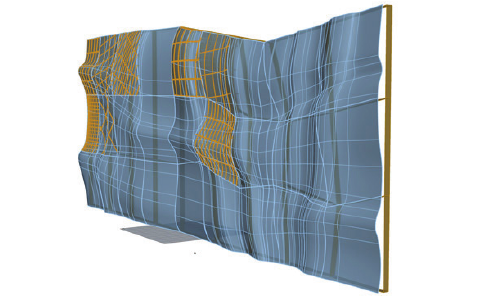
Figure 2. Entire wall panel sized 540x210 cm where several cells have applied the early stage cuts in non-standard angles